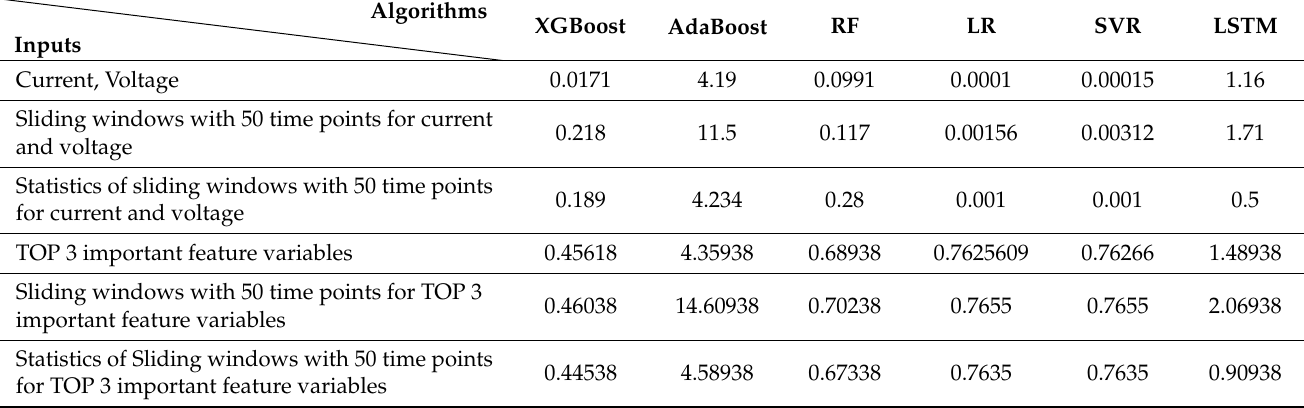
Table 8. The total time consumption of the integrated algorithms for test set data